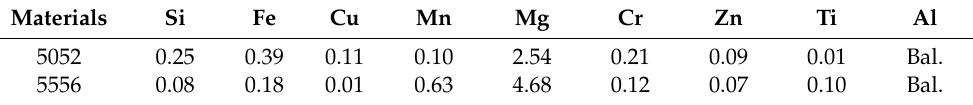
Table 5. Chemical composition of the substrate and additive material (mass